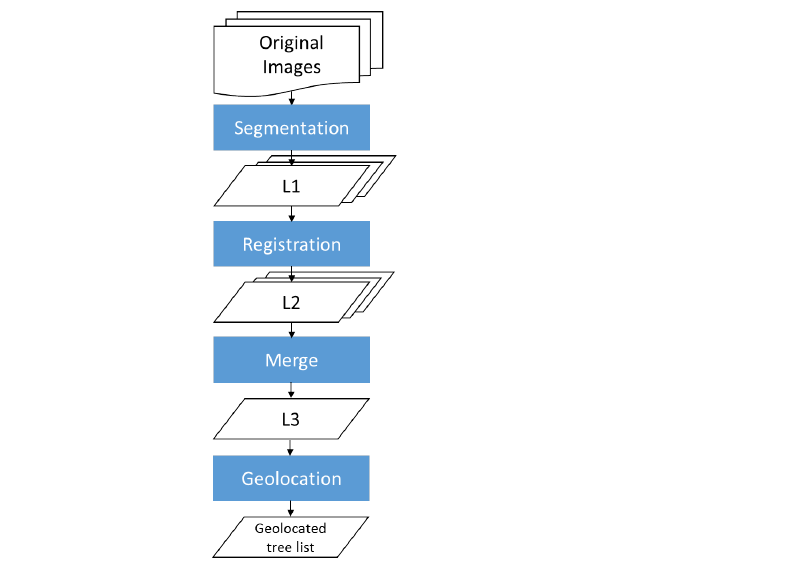
Figure 3. Tree counting data processing flow (L1 is a list with the pixel coordinates of the trees detected in one image; L2 is the same list with pixel coordinates projected to a global reference system; and L3 is a global list with the coordinates of the trees detected in all the processed images without duplicates).